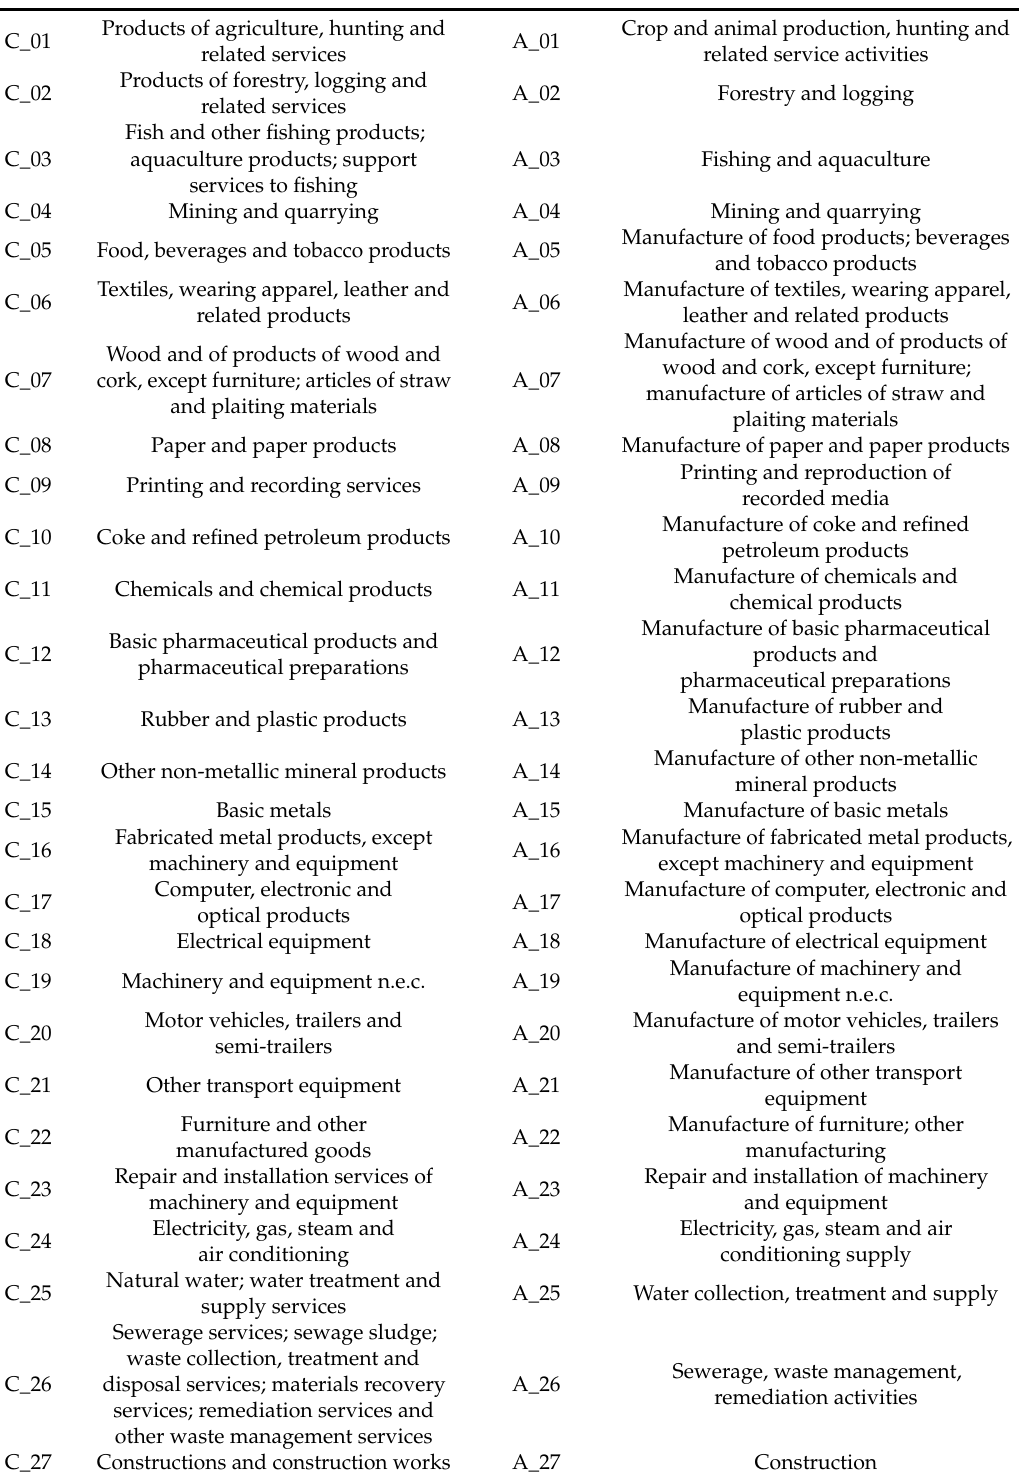
Table A1. Products and activities used in EU28 SAMs